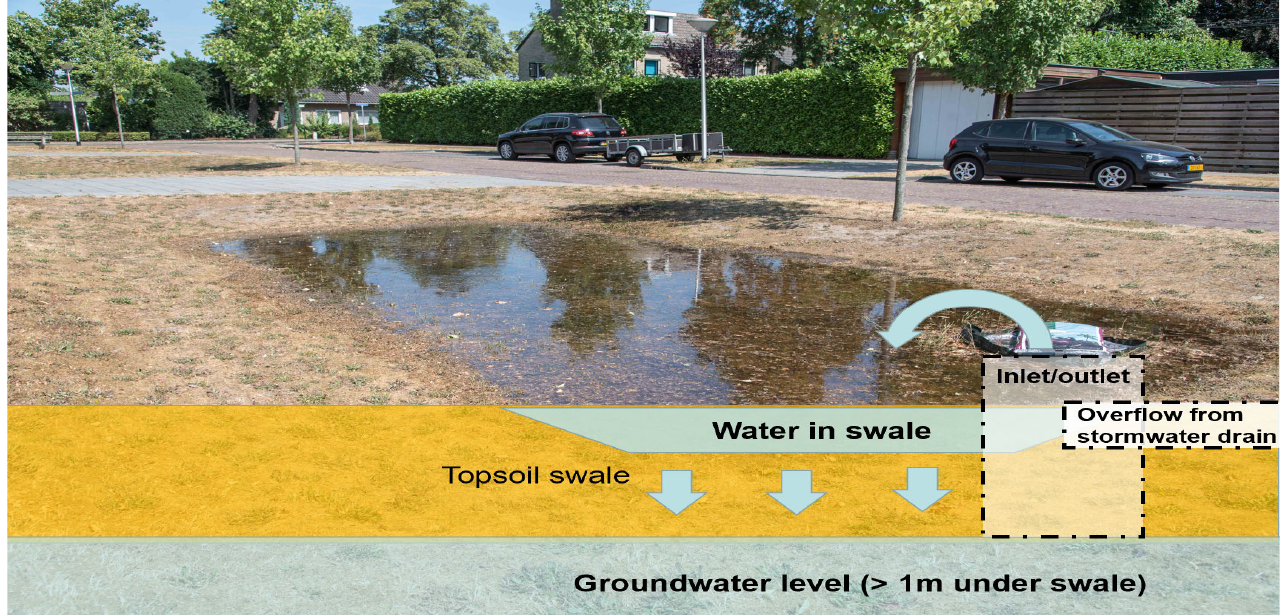
Figure 3. The swale construction in the municipality Dalfsen, The Netherlands.